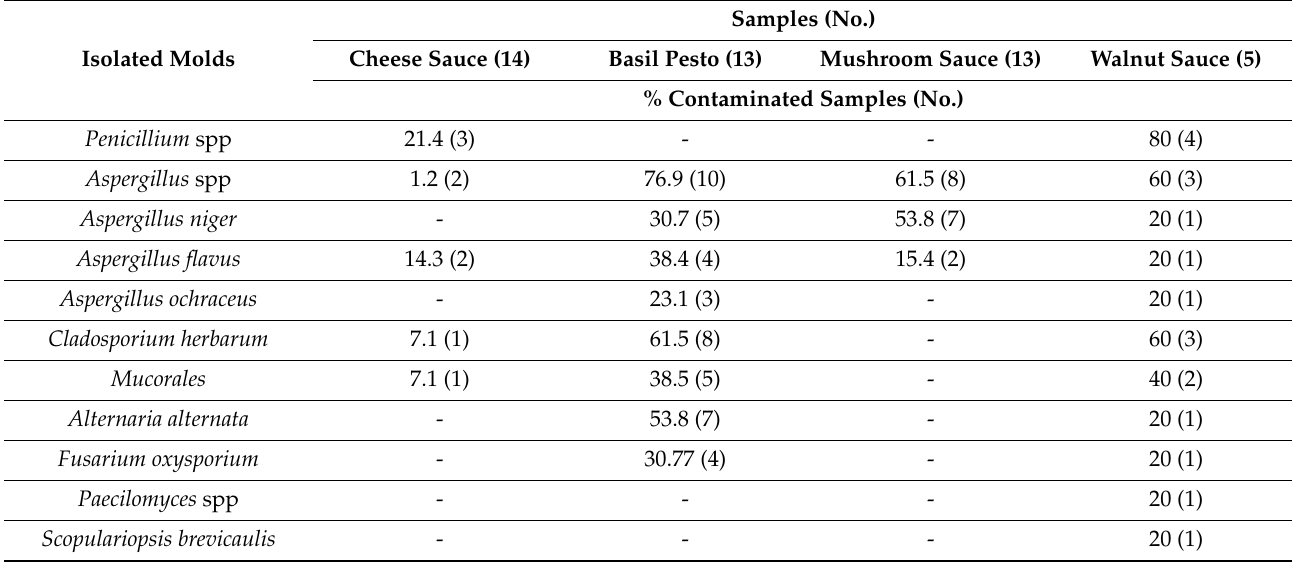
Table 3. Mold species isolated by cheese sauce, basil pesto, mushroom sauce and walnut sauce